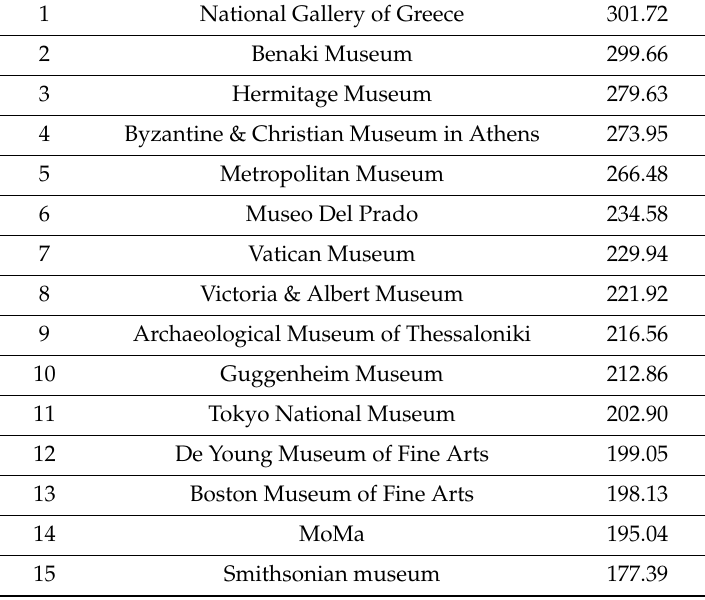
Table 4. The final ranking of the websites based on the values calculated by weighted product model (WPM) and presented in F WPM